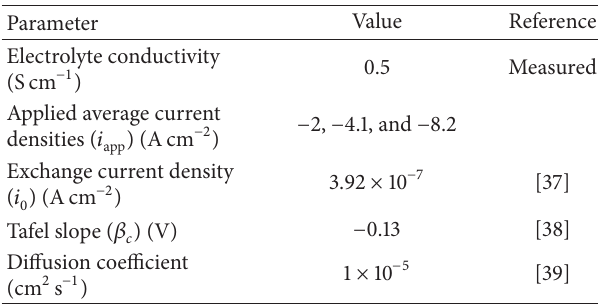
Table 1: Transport and kinetic parameters used in the numerical